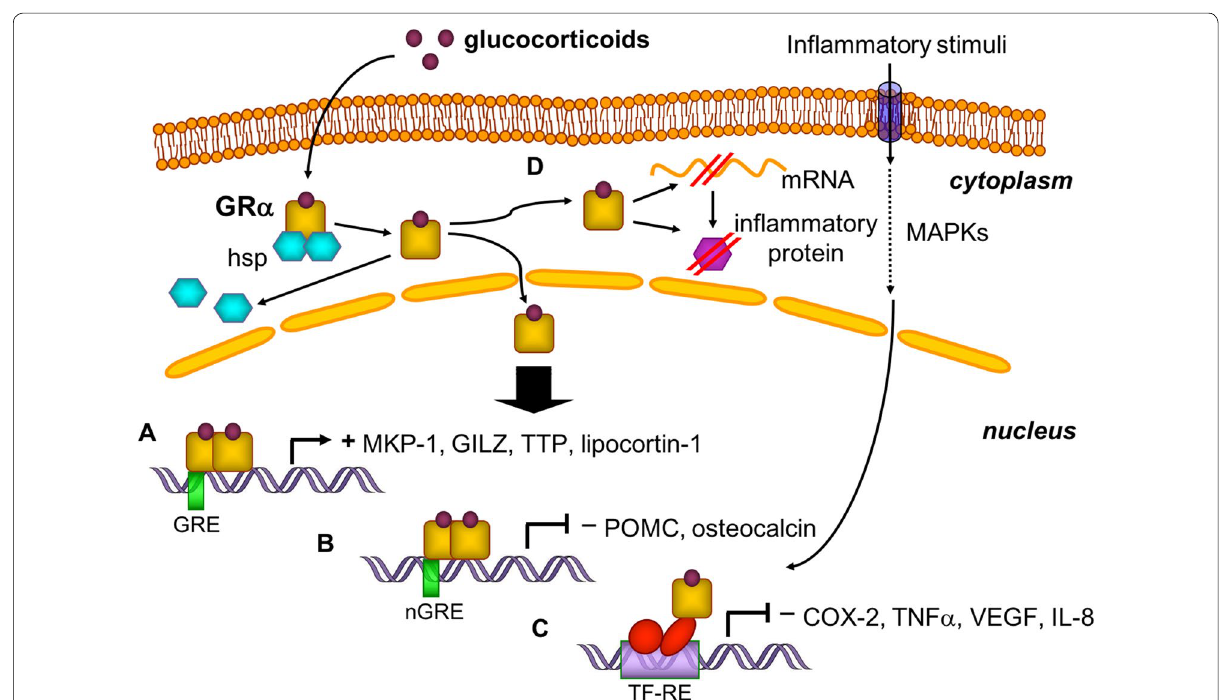
Fig. 2 Molecular mechanisms of glucocorticoid action. After crossing the cell membrane by passive diffusion, glucocorticoids bind to GRα, associated heat‑shock proteins (HSP) are released, and the ligand bound receptor translocates into the nucleus. Through the activation of MAP kinase (MAPKs) intracellular cascade, inflammatory stimuli induce the production of transcription factors. A GRα dimer can bind glucocorticoid responsive elements (GRE) on the promoter region of target genes and activate anti‑inflammatory gene (MKP‑1, GILZ, TTP, lipocortin‑1) transcription. B Binding of GRα to a negative GRE (nGRE) leads to gene (POMC, osteocalcin) repression. C Protein–protein interactions between GRα and transcription factors (AP‑1, NF‑κB) repress the transcription of pro‑inflammatory genes (COX‑2, TNF‑α, VEGF, IL‑8). D GRα can alter mRNA or protein stability of inflammatory